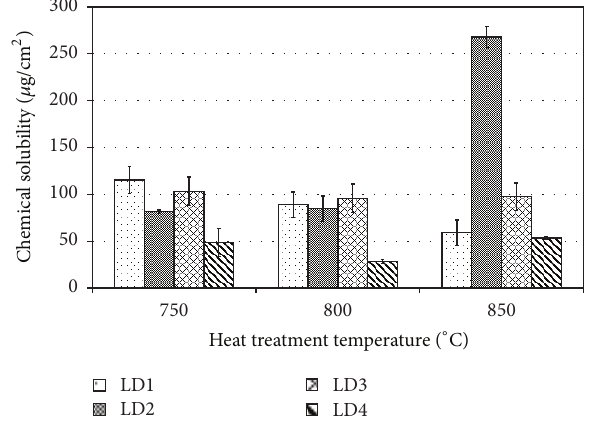
Figure 8: The chemical solubility of LD1, LD2, LD3, and LD4 at different heat-treated temperatures for